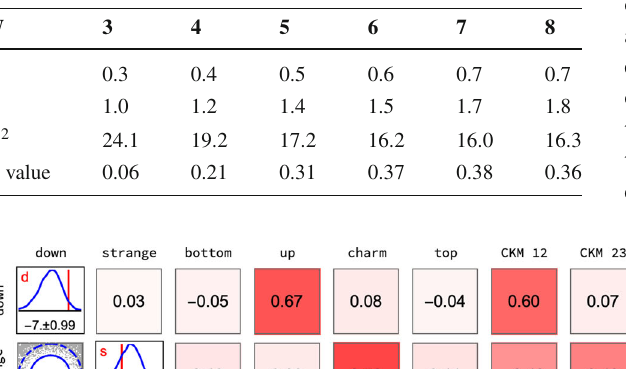
Table 7 Simulation for the SO ( 10 ) model, with tan α = − 0 . 6 and tan β = 50. The χ 2 corresponds to 15 degrees of freedom. The row marked p value gives the proportion of models with lower probability density (larger χ 2 ) than the standard model